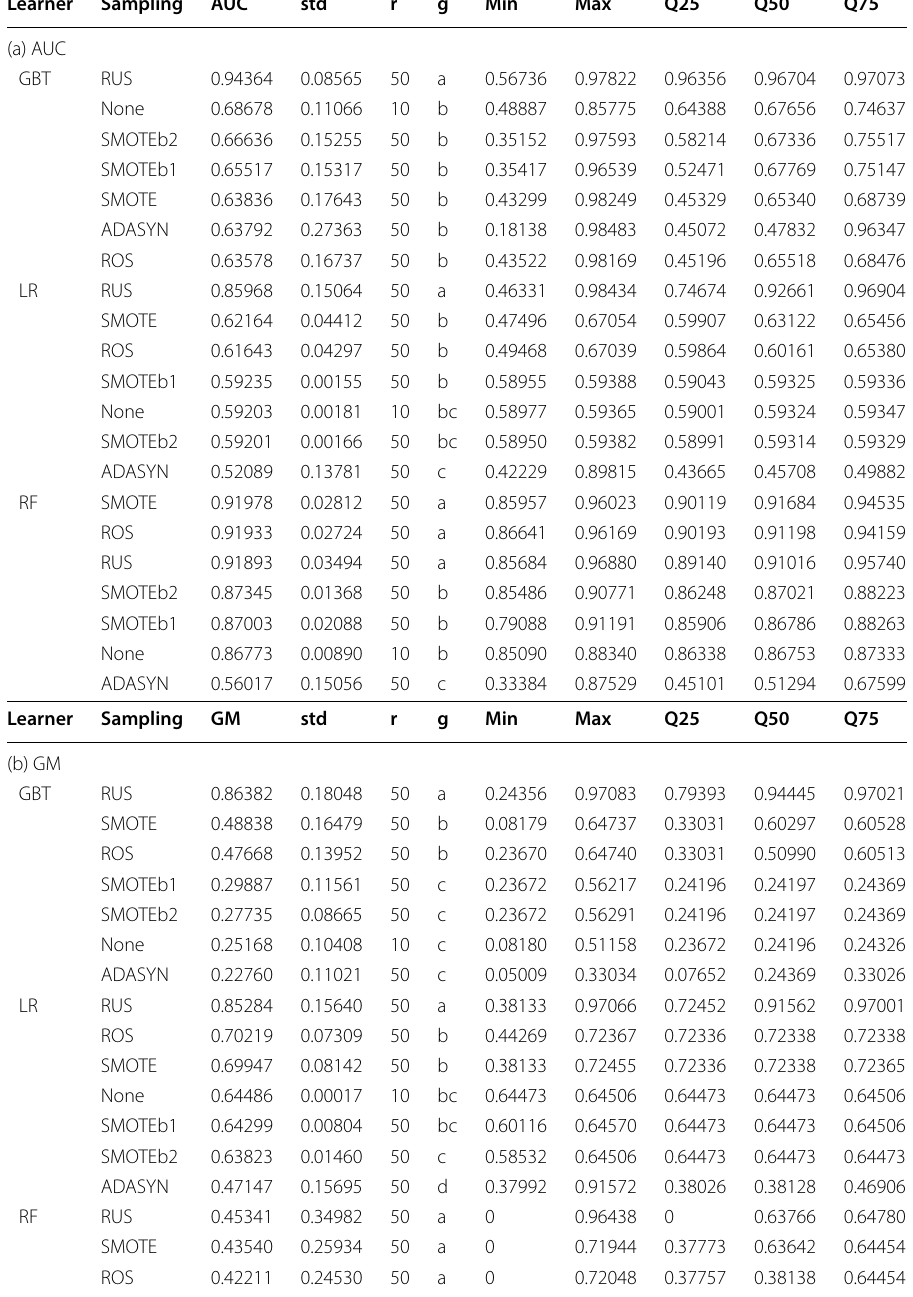
Table 7 Case 2: SlowlorisBig-Tukey’s HSD test